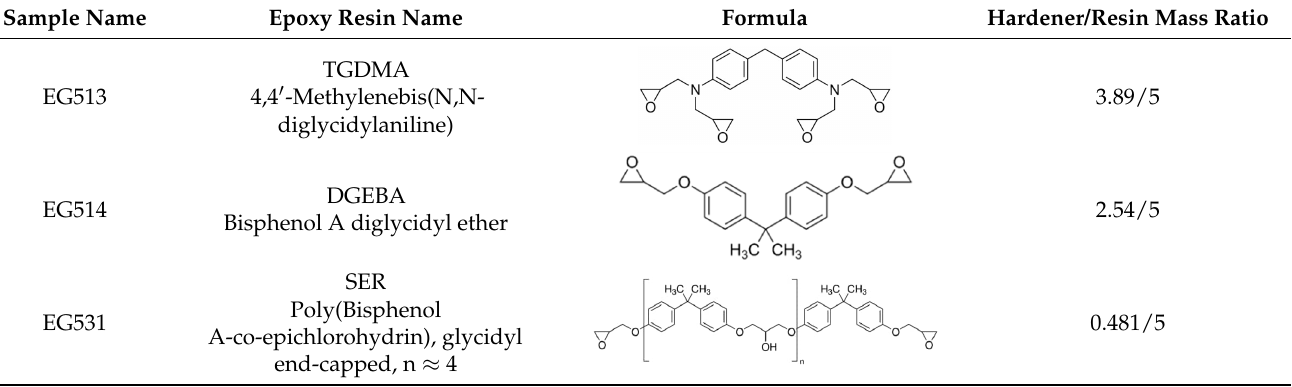
Table 1. Epoxy resins used for compositions with MPD-TPA-MPD hardener and the hardener/resin mass ratio.